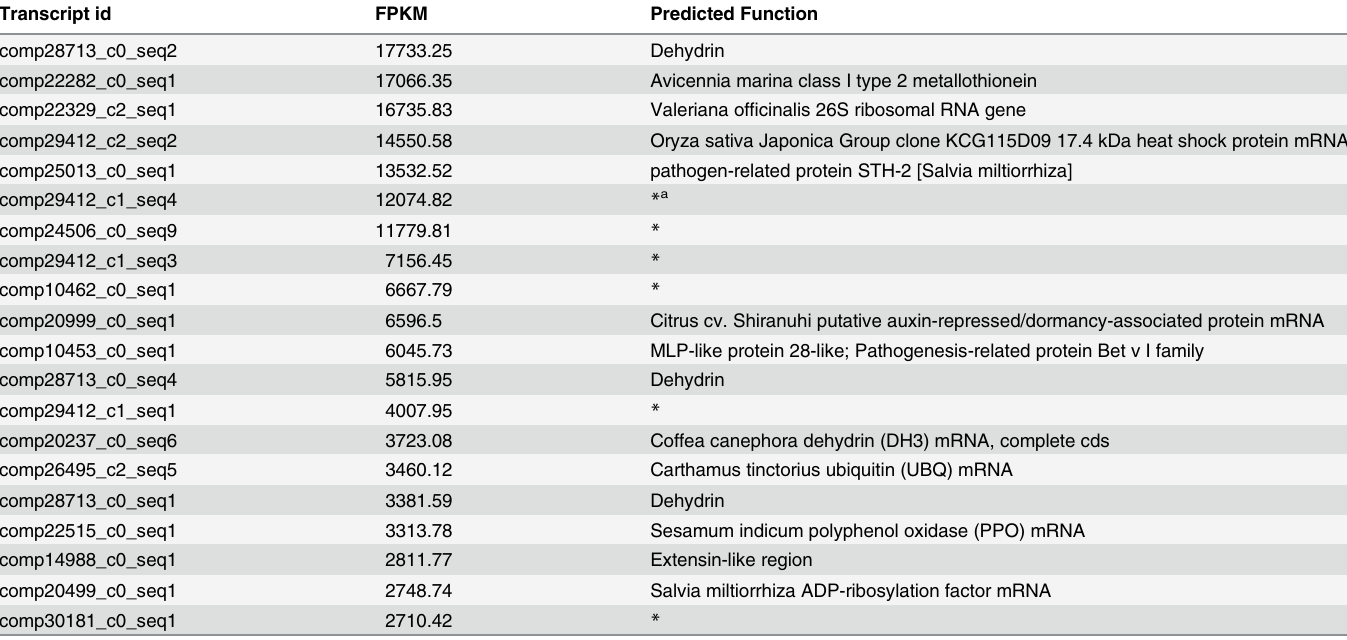
Table 2. The top 20 highly expressed genes in fleshy stem tissue of C . deserticola